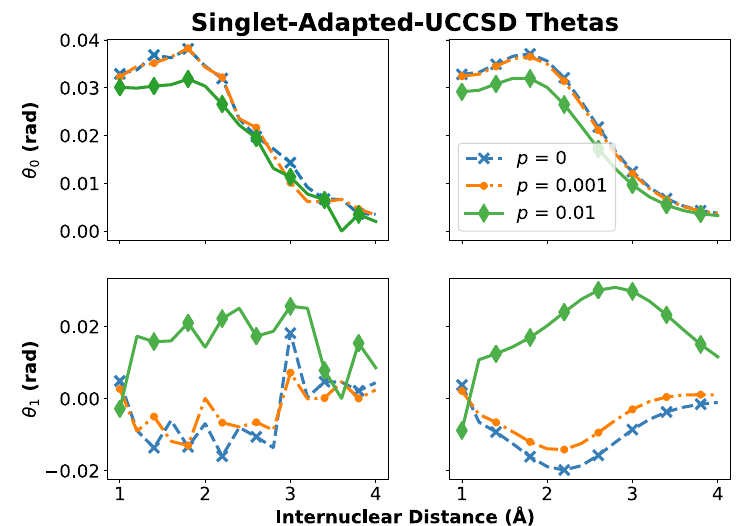
Fig. 7 The optimal values of the circuit parameters (top row) θ 0 and (bottom row) θ 1 for the singlet-adapted UCCSD ansatz as a function of obtained from VQE with respect to the NaH internuclear distance when using the COBYLA (left column) and L-BFGS (right colum) optimization methods